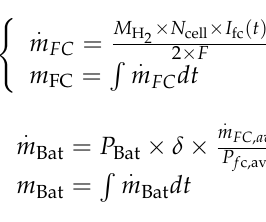
Figure 4. Charging and discharging characteristic curves of ( a ) total internal resistance, ( b ) ohmic internal resistance, ( c ) polarization internal resistance and ( d ) polarization capacitance.